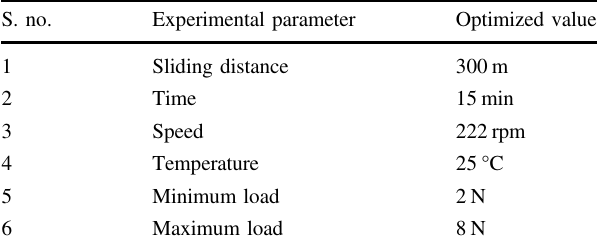
Table 3 Optimum experimental parameters applied for wear-resistance measurement S. no.